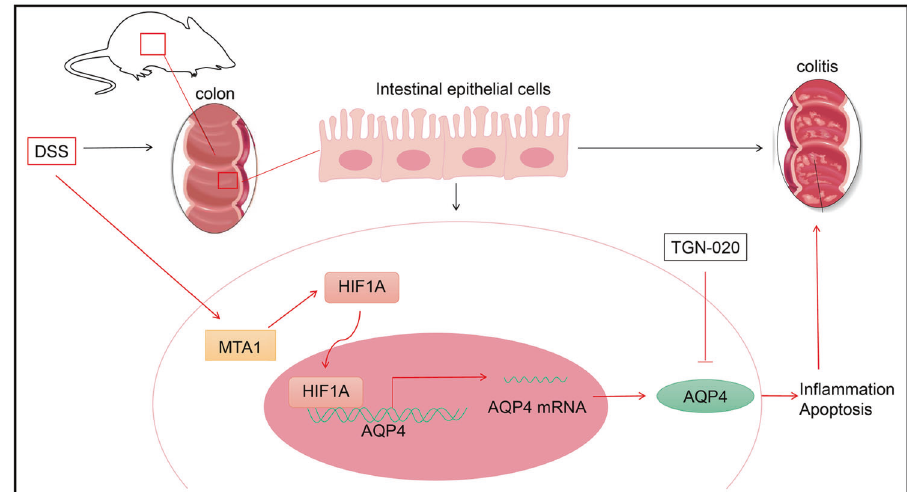
Fig. 7 The molecular mechanism of the abnormal expression pattern of AQP4 in the development of experimental colitis in mice. MTA1 can activate HIF1A to induce the binding of HIF1A in the promoter region of AQP4, and thus promote the expression pattern of AQP4, thereby promoting the occurrence of in fl ammatory response and apoptosis of epithelial cells. Moreover, based on the molecular mechanism, TGN-020, the selective inhibitor of AQP4, can elicit an alleviatory role in experimental colitis in